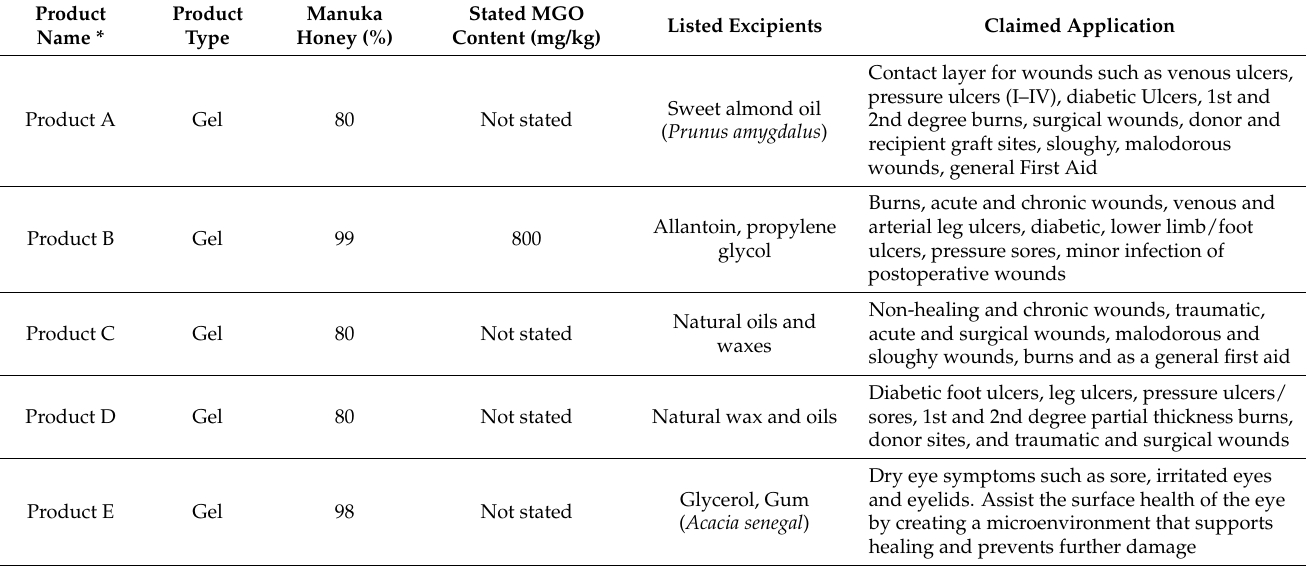
Table 3. List of commercial